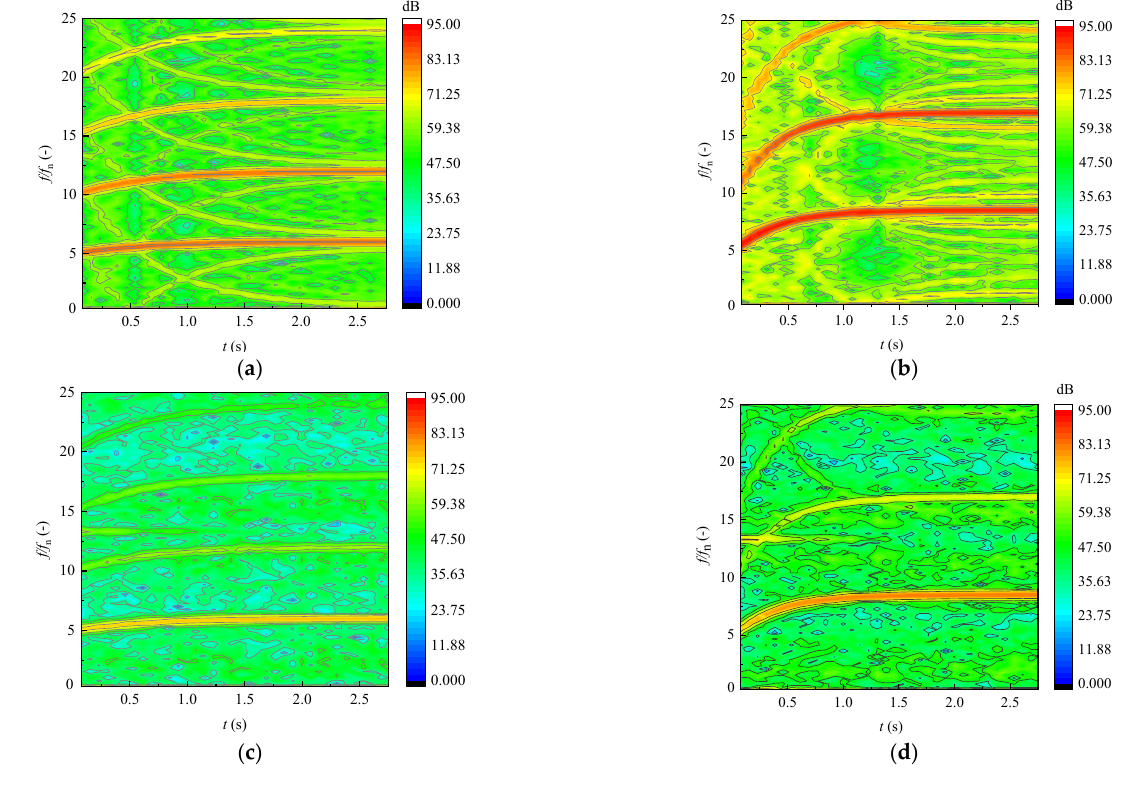
Figure 14. Time–frequency analysis of the pressure signals at points M2 and M3. ( a ) 0.85 Q BEP —M2. ( b ) 1.1 Q BEP —M2. ( c ) 0.85 Q BEP —M3. ( d ) 1.1 Q BEP —M3.